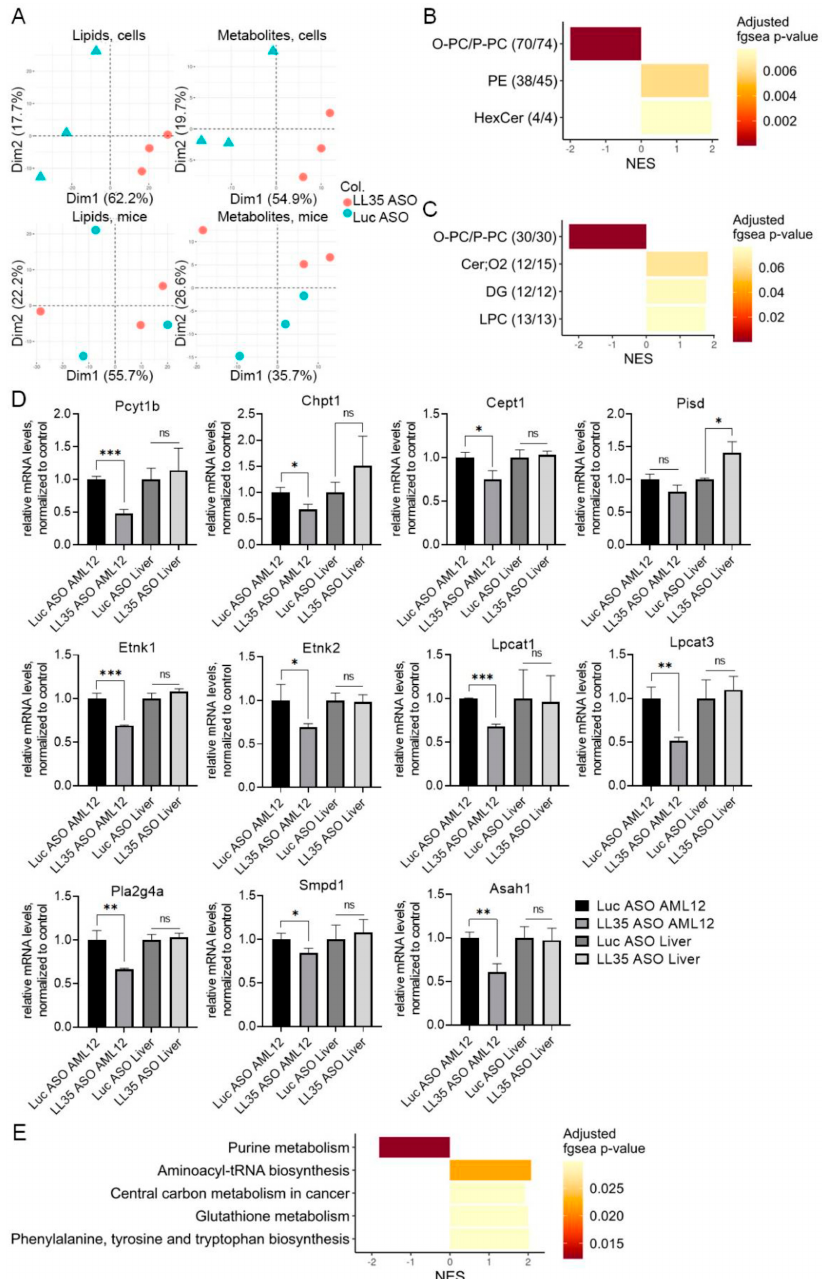
Figure 4. Lipidome and metabolome analysis of AML12 cells and murine liver after LL35 inhibition. ( A ) PCA of lipids and metabolites from AML12 cells and liver samples with depleted LL35 (LL35 ASO) and control (Luc ASO), polarities merged. Lipid abundance alteration in ( B ) AML12 cells; ( C ) murine liver, classes that are significant both before and after confirmation (fgsea FDR < 10%). Numbers in brackets: the number of confirmed features and the total number of features. ( D ) RT-qPCR analysis of expression levels of key genes, which participate in synthesis and breakdown of significantly changed lipids classes after LL35 knockdown (LL35 ASO) and control (Luc ASO), normalization on ACTB gene. ( E ) KEGG pathways, metabolites from which are significantly influenced by LL35 knockdown in AML12 cells. NES—normalized enrichment score. Results show mean ± SD. ns—not significant. * p < 0.05, ** p < 0.01 and *** p <